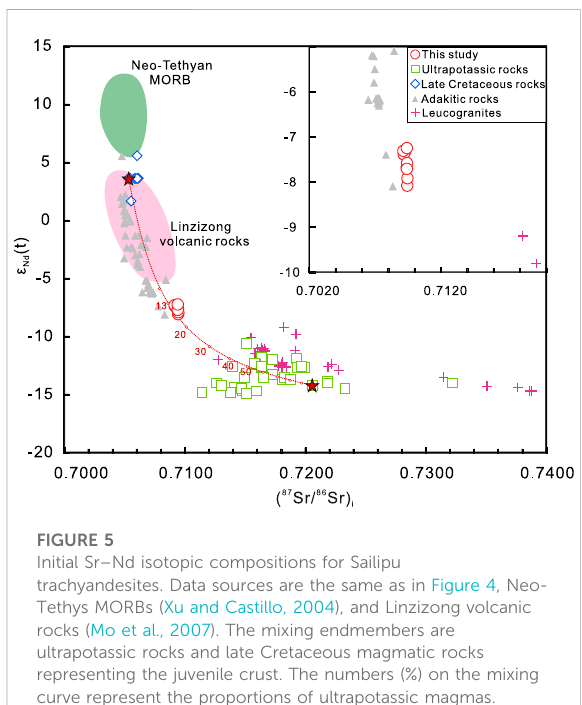
FIGURE 5 Initial Sr – Nd isotopic compositions for Sailipu trachyandesites. Data sources are the same as in Figure 4, Neo- Tethys MORBs (Xu and Castillo, 2004), and Linzizong volcanic rocks (Mo et al., 2007). The mixing endmembers are ultrapotassic rocks and late Cretaceous magmatic rocks representing the juvenile crust. The numbers (%) on the mixing curve represent the proportions of ultrapotassic